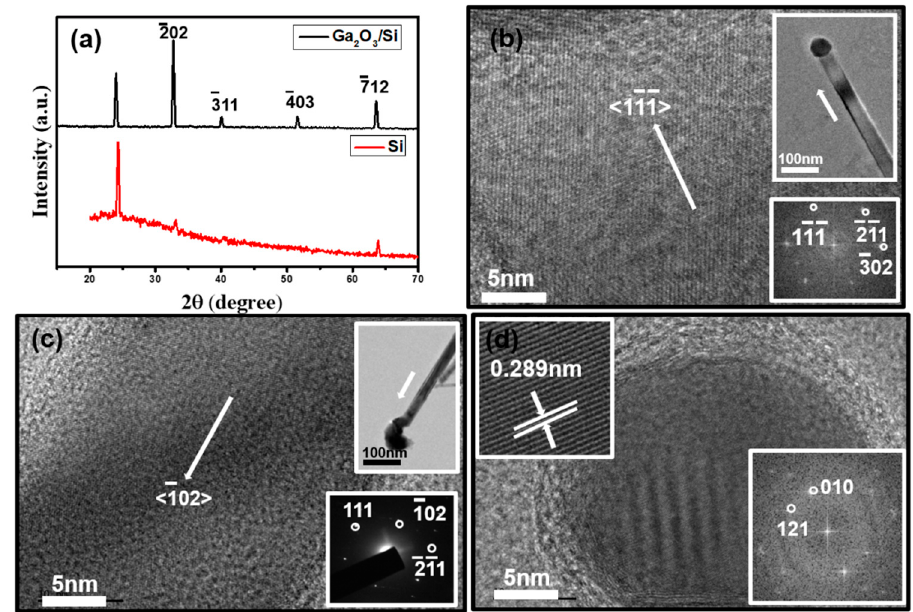
Figure 4. Crystal structure characterizations of the NWs. ( a ) XRD patterns of the NWs and the Si/SiO 2 substrate, ( b ) HRTEM image of NW grown along the ⟨ 1 1 (cid:3364) 1 (cid:3364) ⟩ direction, according to FFT images in the inset for one of a representative Ga 2 O 3 NWs, ( c ) another NW grown along the ⟨1(cid:3364) 02 ⟩ direction as identified by the SAED pattern in the inset, and ( d ) HRTEM image and FFT (inset) of the Cu 5 As 2 alloy tips.